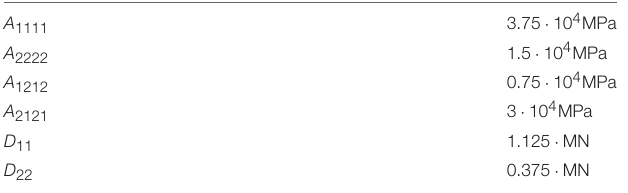
TABLE 1 | Constant mechanical properties used in all computations.